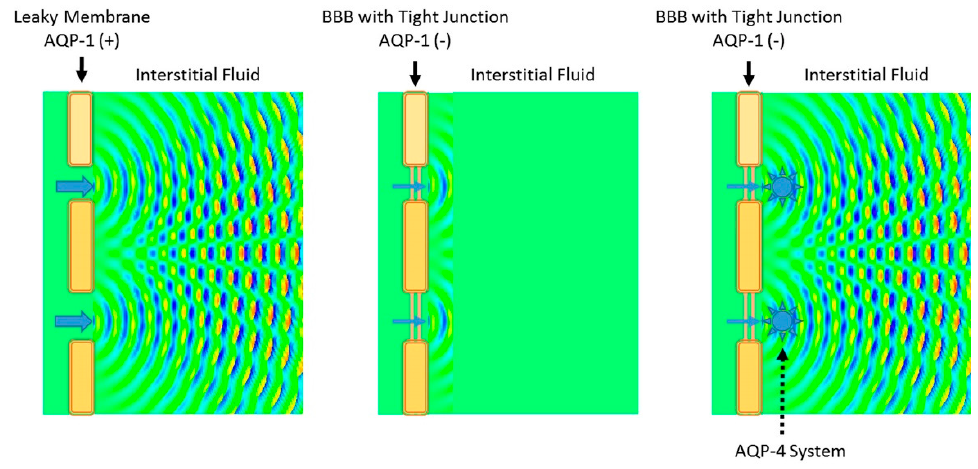
Figure 6. Schematic presentation of wave propagation simulation for conceptualizing water dynamics inside the BBB. From a hydrodynamic standpoint, the tight endothelium of brain capillaries forming the BBB is seriously flawed. While hydrostatic pressure generated by the systolic force of the heart (blue arrow) provides the necessary kinetics in the case of fenestrated capillaries ( left ), sealed capillaries impede propagation of such a force ( middle ). The addition of AQP-4 driven water flow reconstitutes the necessary environment ( right ). Diagrams are created using wave propagation/interference simulation for two windows.